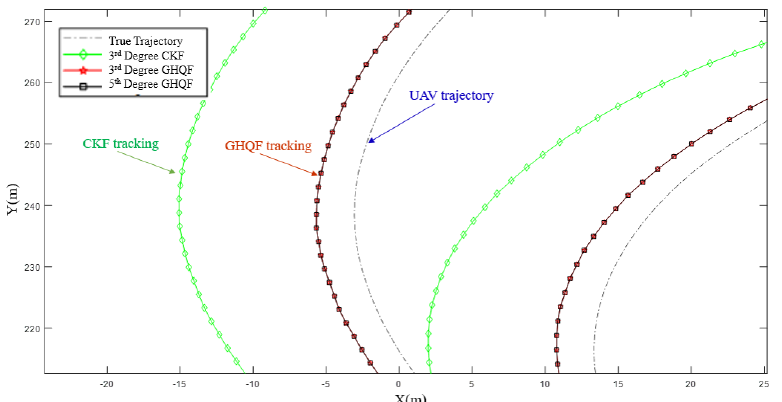
Figure 14. Zoom-in of Figure 13—From the result, one can note that high-nonlinearity filtering of